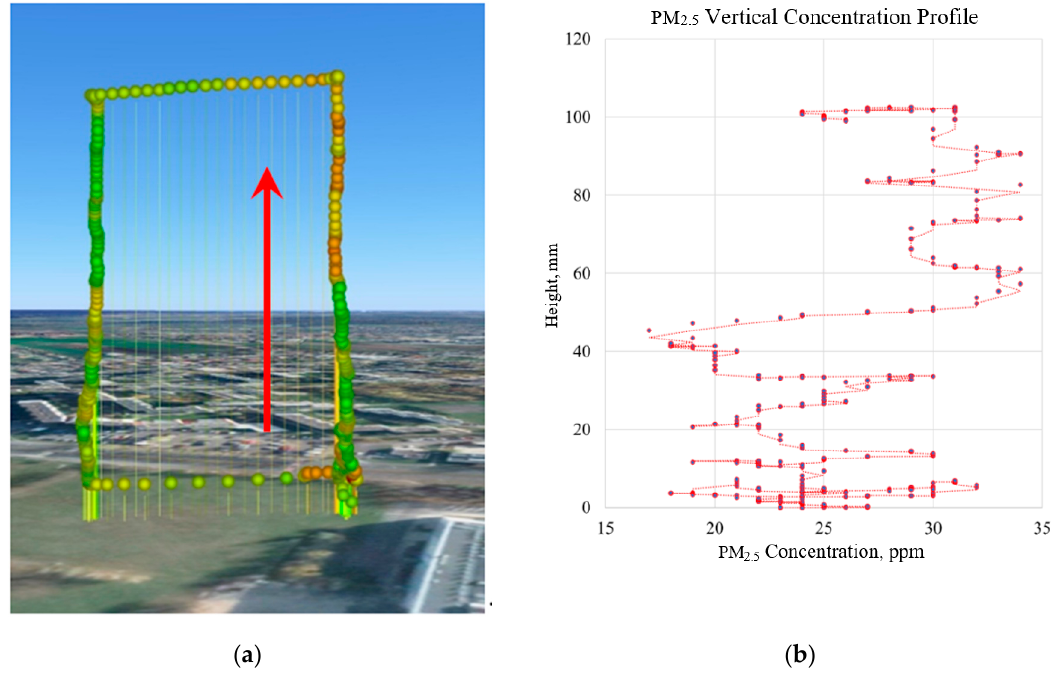
Figure 10. Flight route and measurement points visualization ( a ) for vertical concentration profile of PM 2.5 ( b ) for location number 1 (see Figure 1)—red arrow indicates ascending flight and data for the visualization chart.